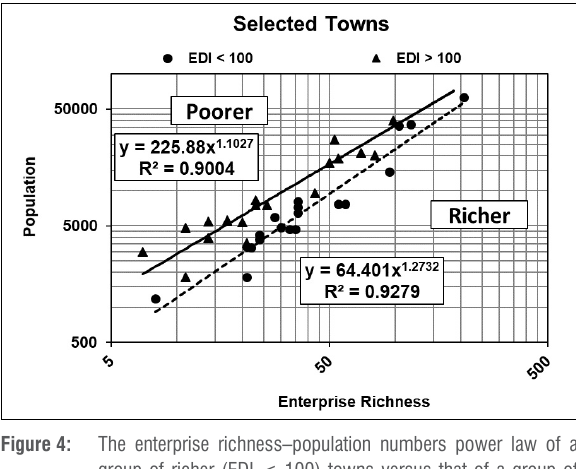
The enterprise richness–population numbers power law of a group of richer (EDI < 100) towns versus that of a group of poorer (EDI > 100) towns.